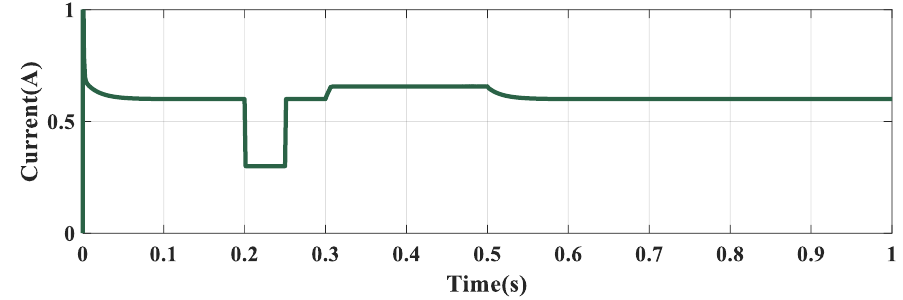
Figure 31. Study 4: load current (fixed weighting